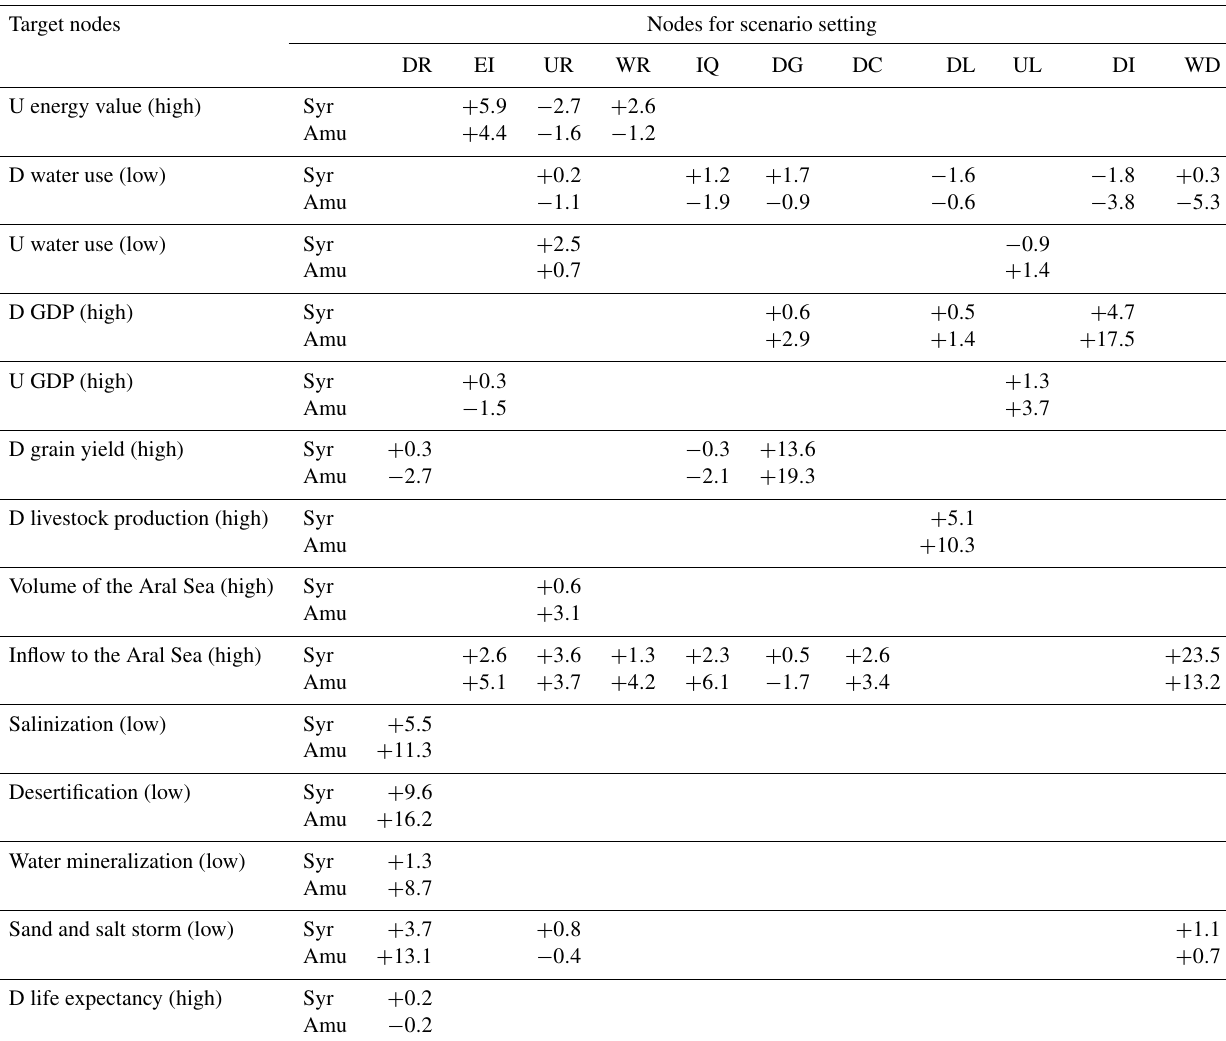
Table 3. Comparison of the BN-based scenario analysis of the SDB and ADB. Target nodes Nodes for scenario